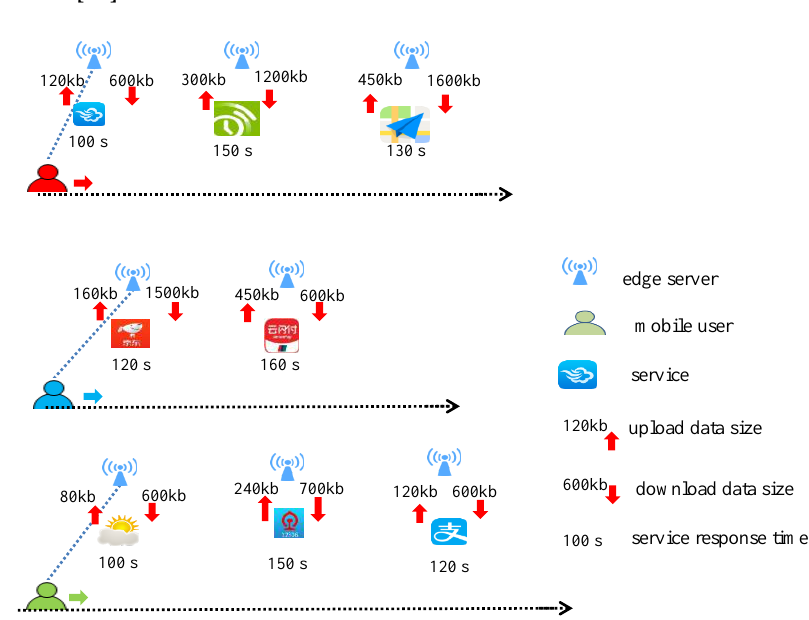
Figure 2. Examples of service